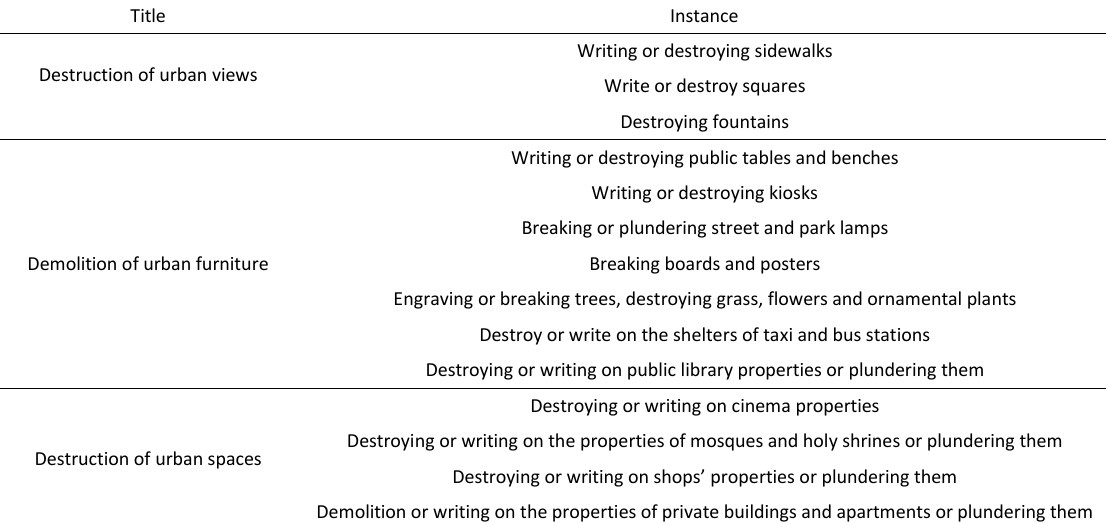
Table 3: The effects of vandalism on the beauty of Chenaran City (extracted from the content analysis of focus group interviews)